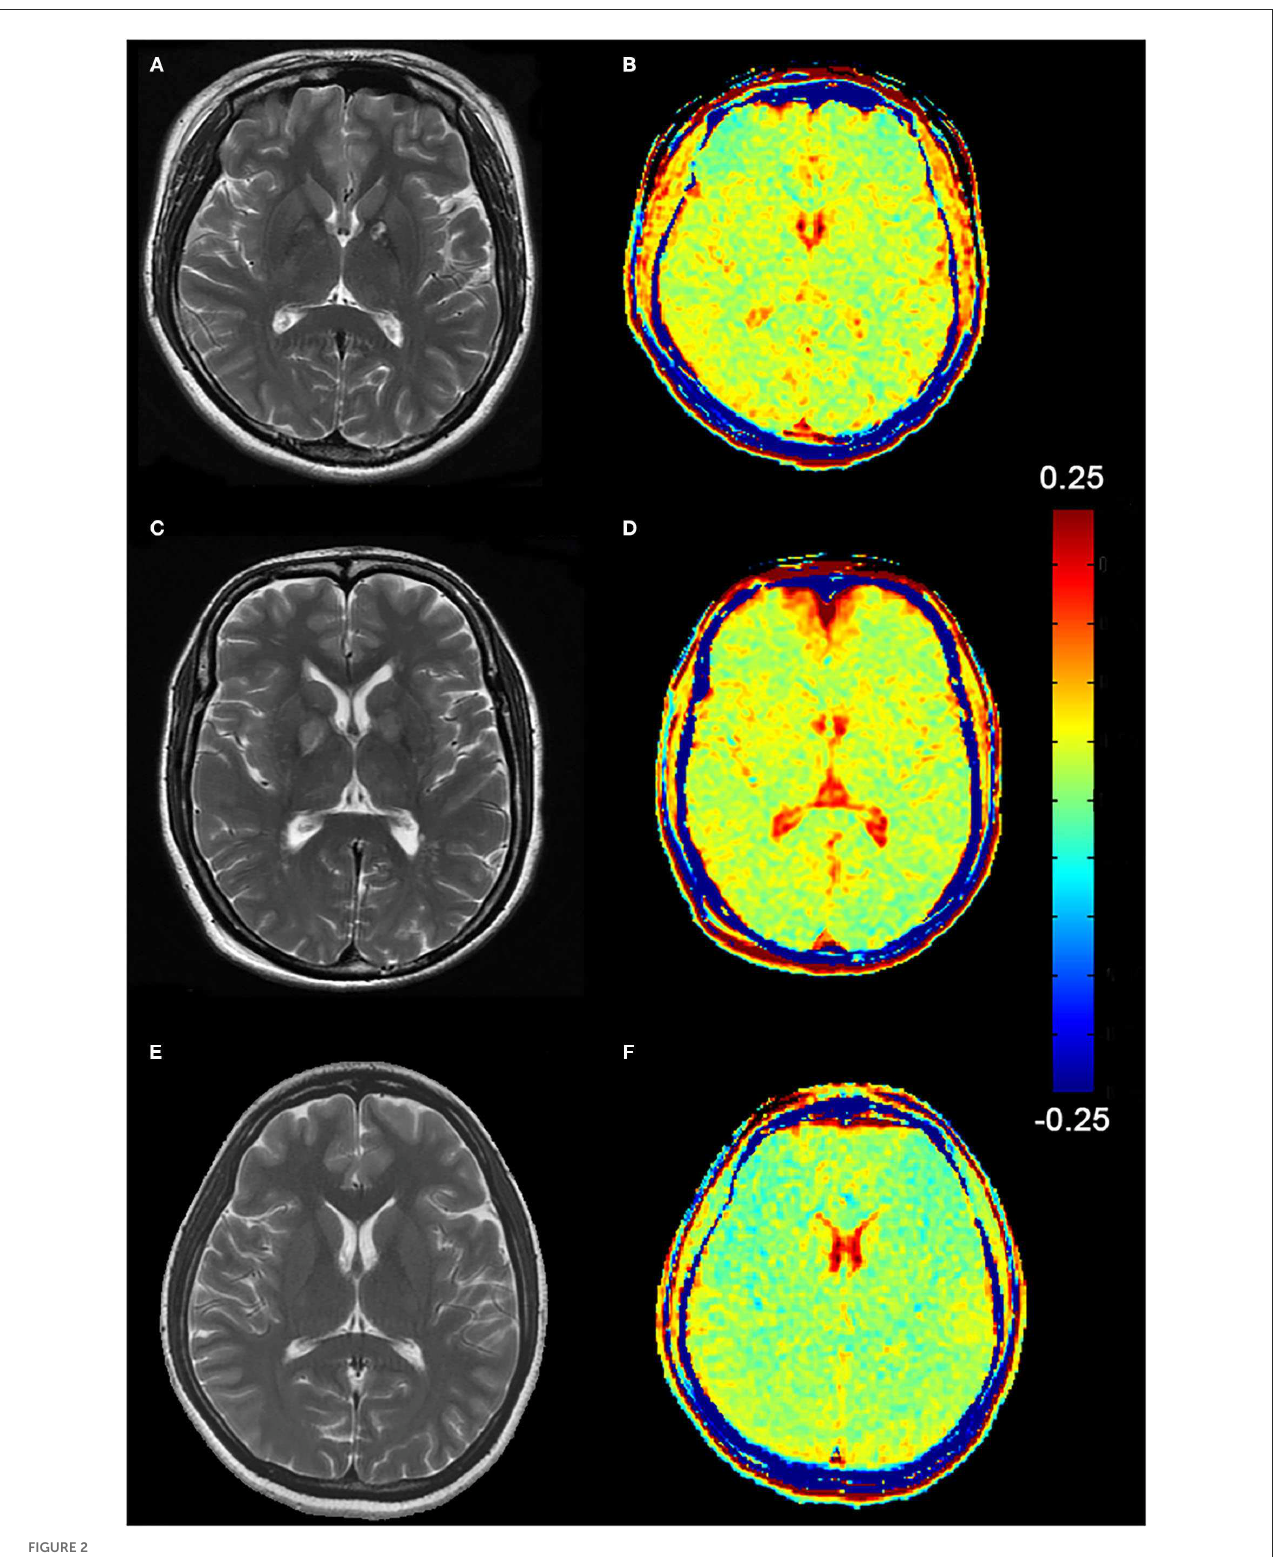
FIGURE2 (A, C) Abnormal T2WI images of two female patients (Patient A, 24-year-old and Patient C, 47-year-old), mainly manifested in the bilateral globus pallidus. (B, D) Higher signals on GluCEST images present in the globus pallidus and the cerebral white matter region. (E, F) T2WI and GluCEST images of a healthy adult (female,